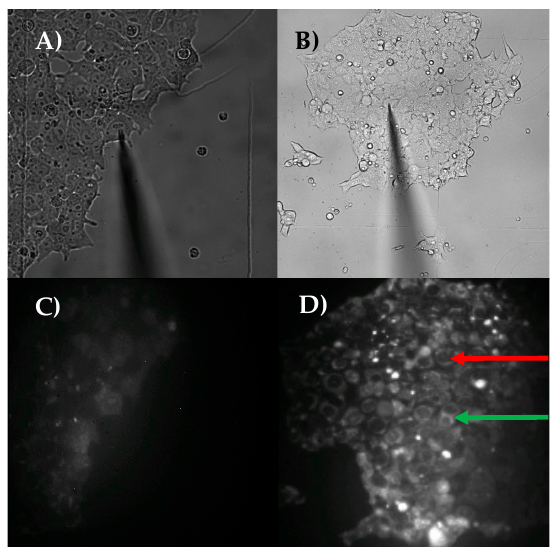
Figure 3. Aspiration of nuclear content by Nanopipette. ( A ) Nanopipette is placed on top of MCF-7 cell; ( B ) Nanopipette is placed on top of a different MCF-7 cell; ( C ) Fluorescence corresponding to mitotracker orange staining of cells depicted in ( A ); ( D ) Fluorescence corresponding to mitotracker orange staining of cells depicted in ( B ). Nuclear region is visualized by pattern of staining with the mitotracker dye. In ( D ) red arrow points dark compartment, corresponding to one nucleus. Green arrow shows one cytoplasmic region. Nanopipette was inserted into the nucleus, as seen in ( B ). Nuclear content was aspirated and transferred to the cDNA synthesis master mix, followed by sequencing using the Illumina Miseq. (Pourmand Lab, Personal Communication, 2018). Cells 2018 , 7 , x